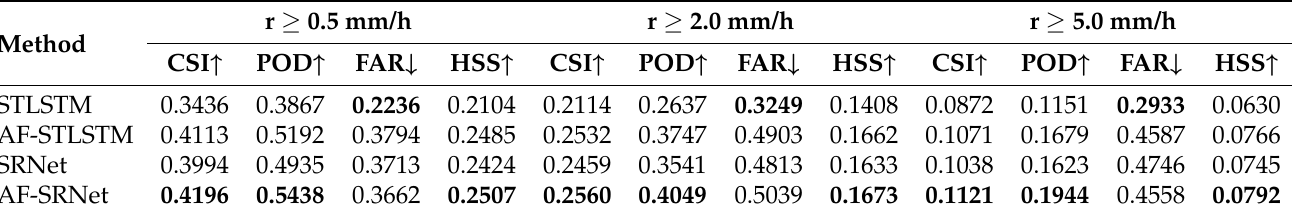
Table 6. Average evaluation results of two frames of precipitation amount nowcasting in the first two hours. The best performance is highlighted in bold. ” ↑ ” means that the higher the score, the better, while “ ↓ ” means that the lower the score, the